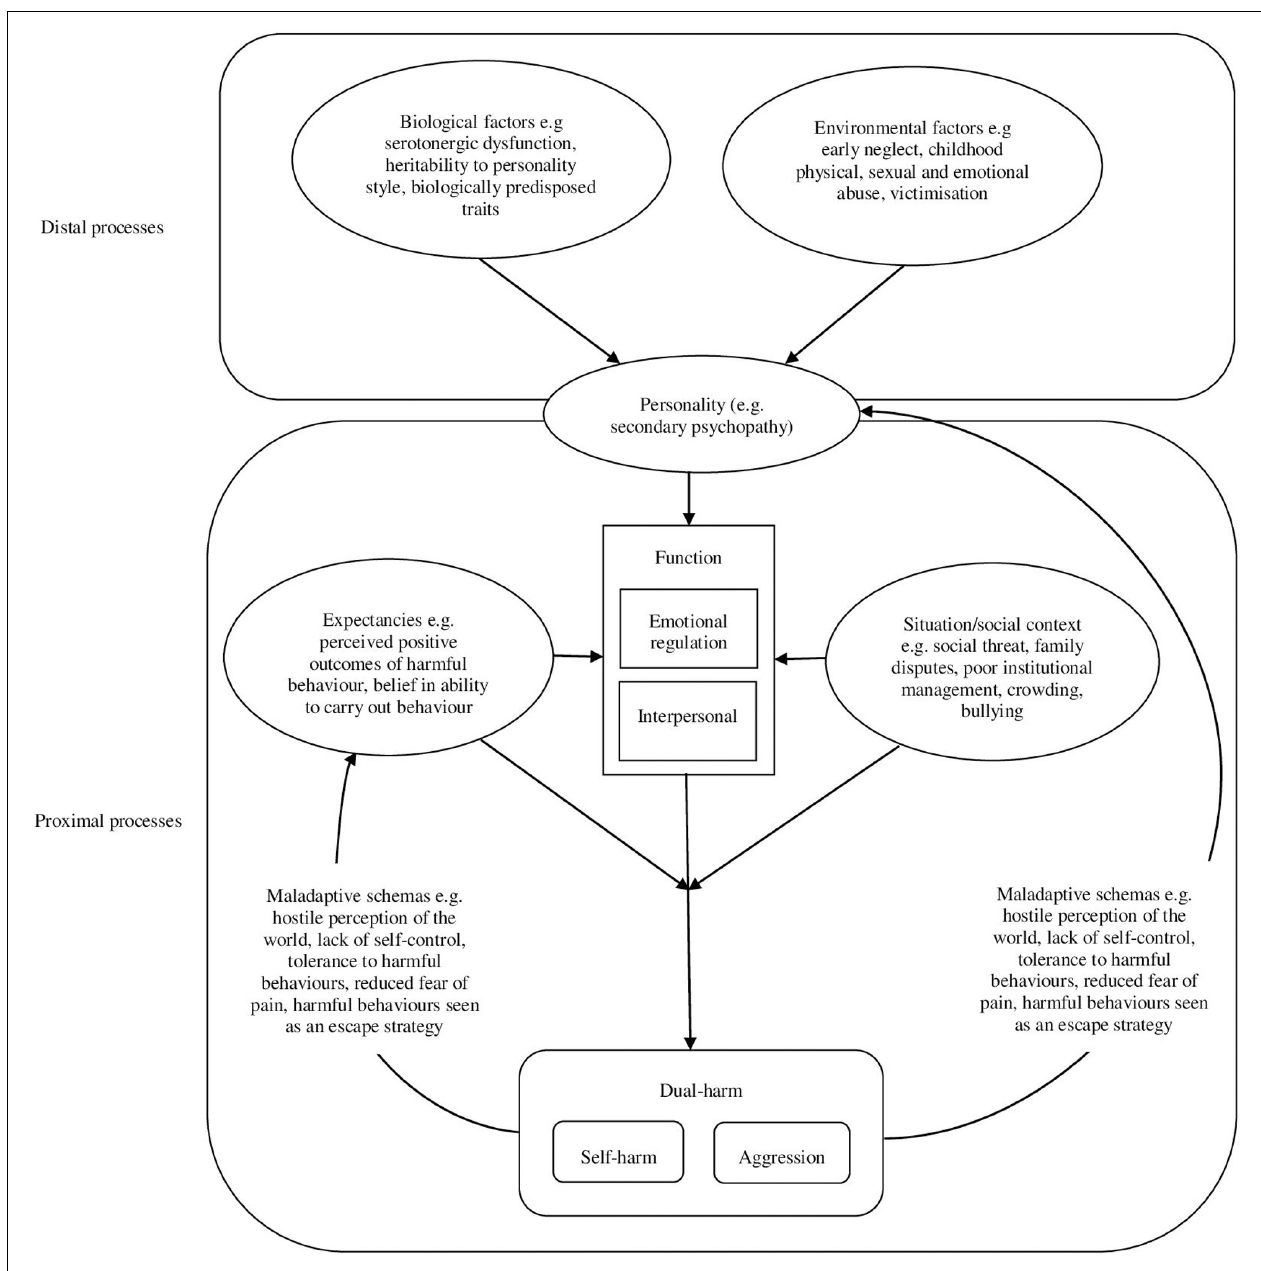
FIGURE 4 | The cognitive-emotional model of dual-harm. This figure illustrates the cognitive-emotional model of dual-harm. Here, the causal pathways to dual-harm are divided into two main processes: distal and proximal. In the distal processes, biological and environmental factors combine to develop a certain personality style. Through its effects on cognition, arousal and affect, this personality style facilitates the proximal processes of dual-harm by predisposing the individual to harmful behaviours. In the proximal processes, the social context/situation the individual is in and their expectancies of harmful behaviours influences the function of their dual-harm behaviour (i.e., emotion regulation or interpersonal motivation), as well as the specific harmful behaviour that they choose to engage in (i.e., self-harm or aggression). Specifically, the individual may choose to engage in dual-harm as an emotional regulation response to their distressing negative emotions. Alternatively, they may choose to engage in dual-harm to fulfil an interpersonal function. Finally, the outcome behaviour affects the environmental response and individual’s experience. Through learning processes, this response may reinforce the individual’s maladaptive schemas and feed back into their personality traits and expectancies, thereby repeating the process of